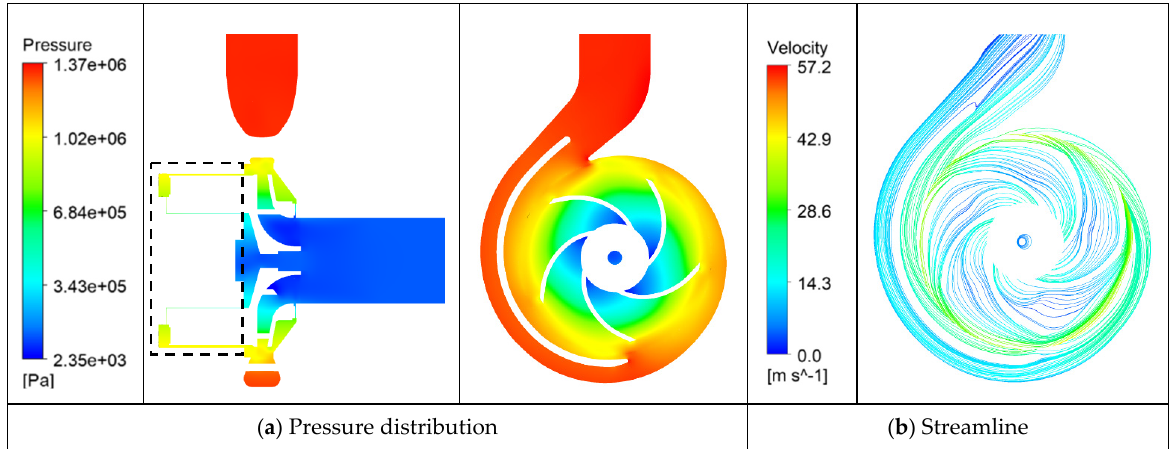
Figure 9. The internal flow field of the magnetic drive